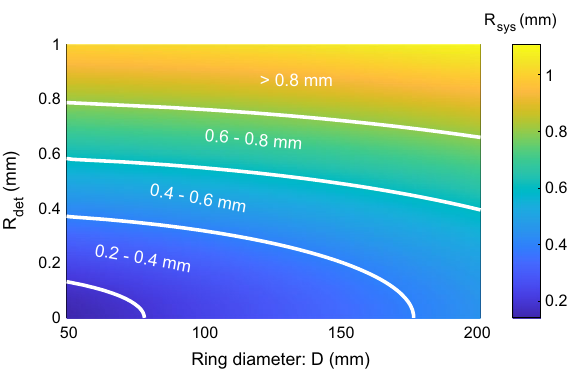
Fig. 12 Fundamental spatial resolution versus ring diameter and detector resolution, assuming a 0.102 mm FWHM positron annihilation point distribution from the 18 F label source [155]. The resolutions are worse for larger ring diameters, which is caused by the noncollinearity of the annihilation photons as shown in formula (1)